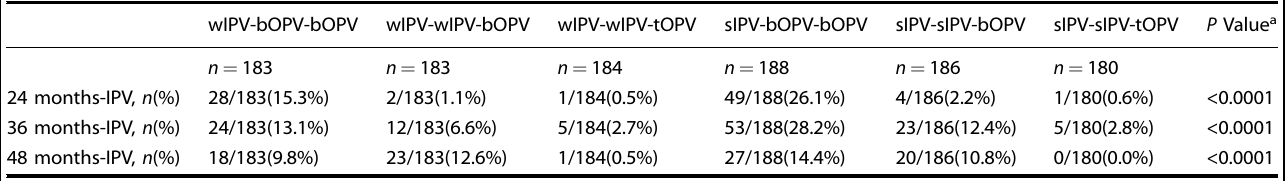
Table 1. Proportion of study participants re-vaccinated with